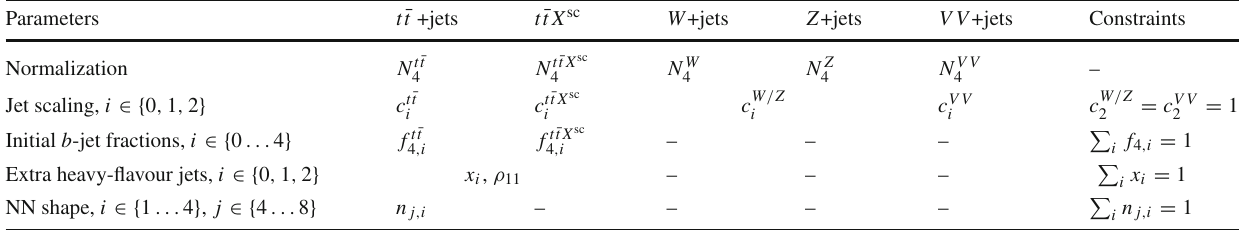
Table 5 Summary of all the free floating parameters in the background model. There are a total of 26 such parameters in the jet counting analysis and 41 in the EWK analysis Parameters t ¯ t +jets V V +jets Constraints